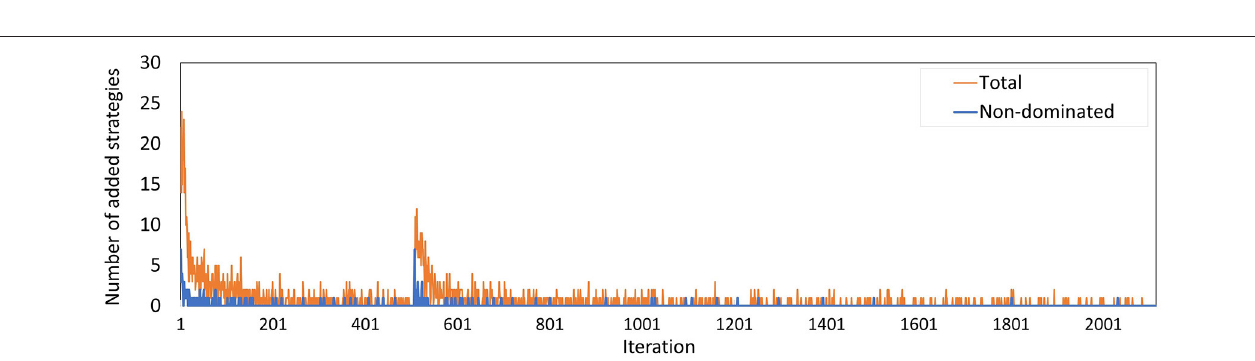
FIGURE 13 | The number of policies added to the memory in each iteration for Experiment 3. The blue line counts all added policies, the orange line only those that are not dominated by (combinations of) other policies in the current memory. The latter are part of the minimal representation of the memory’s approximation set. The peak at iteration 506 is caused by the different seeds used on the virtual machine and the Bebop.